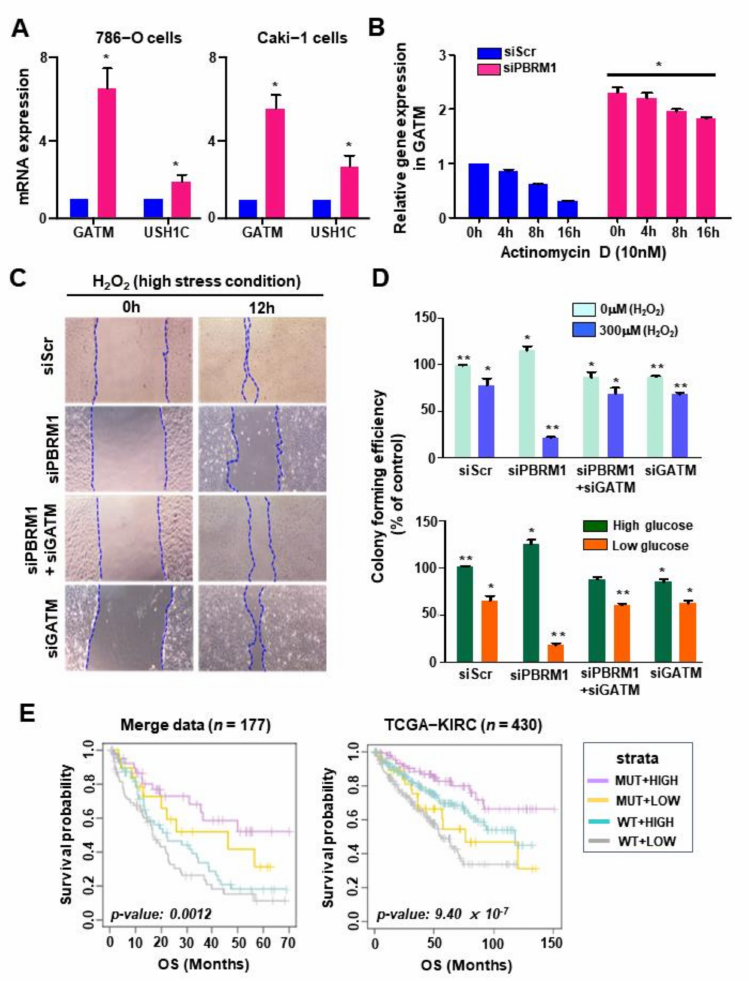
Figure 6. Expression of GATM by PBRM1 knockdown reduces proliferation of clear cell renal cell carcinoma cell lines under stress conditions. ( A ) GATM or USH1C expression levels in PBRM1 knockdown 786-O or Caki-1 cells. The 786-O or Caki-1 cells were transfected with siScr or siPBRM1 and qRT-PCR analysis was performed. ( B ) GATM expression levels in siScr or siPBRM1 were transfected into 786-O cells and treated with 0.5 µ M ActD for the indicated time. ( C ) Wound healing assay was performed. The 786-O cells transfected with indicated siRNAs were incubated with medium containing 300 µ M H 2 O 2 for 12 h. ( D ) Colony formation was performed in PBRM1 knockdown 786-O cells. The 786-O cells were transfected with the indicated siRNAs and